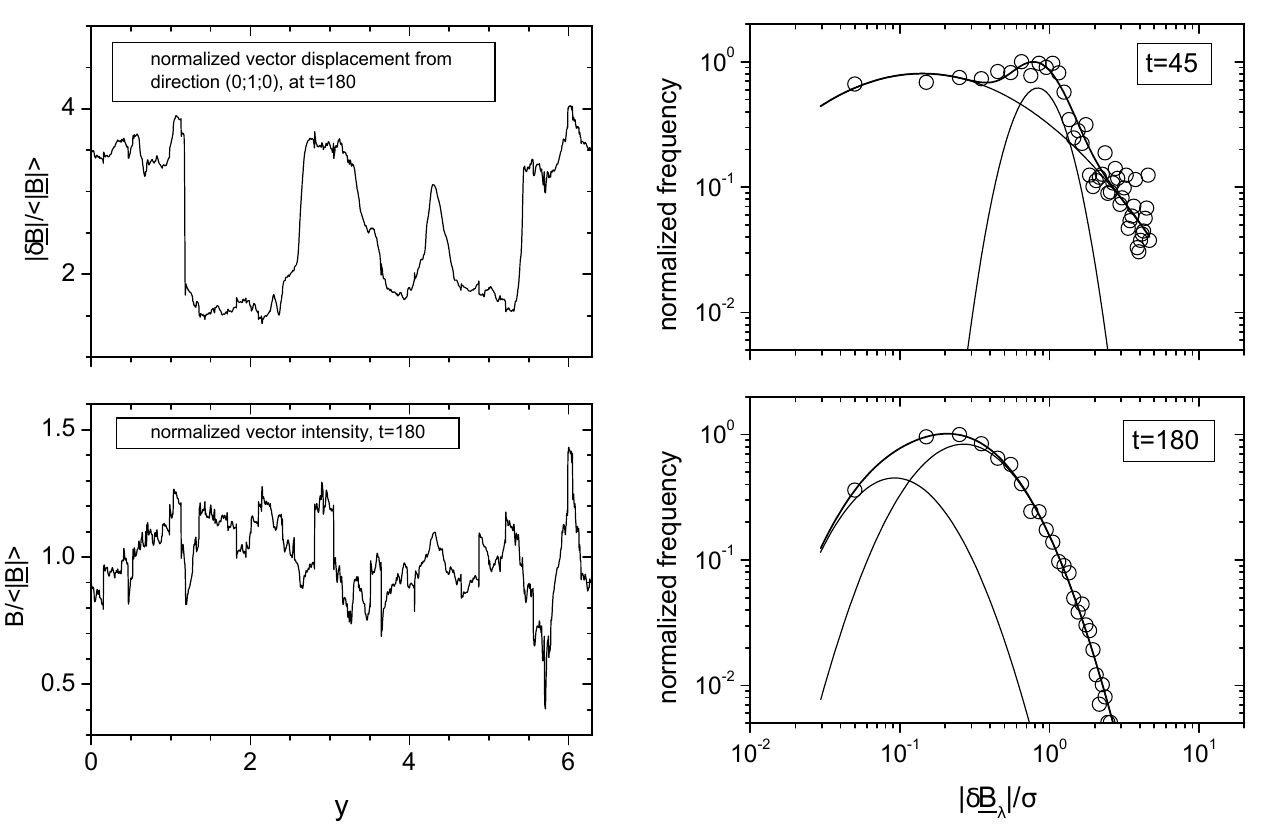
Fig. 20. PDFs of vector displacements | δB λ | , at the scale λ = λ max / 628, normalized to σ for the results of the numerical simulations of the parametric instability at time t = t 1 = 45 τ A and t = t 2 = 180 τ A are shown in the top and bottom panels, respectively. The two thin solid curves refer to as many lognormals contributing to form the thick solid curve which best fits the distribution. Param- eters relative to the fit are reported in Table